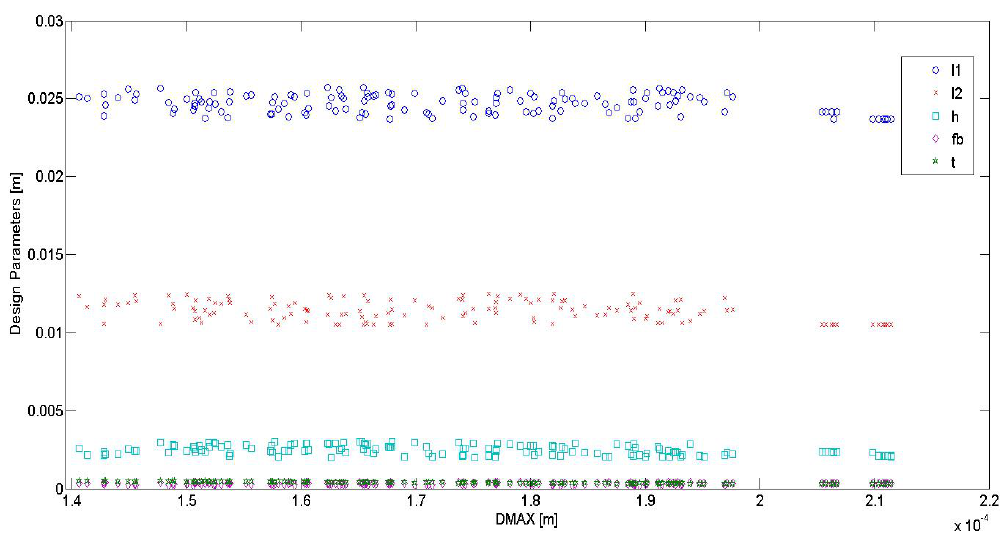
Fig. 5. Plot of design parameters versus design objective (unit: m) Figure 5. Plot of design parameters versus design objective (unit: m).